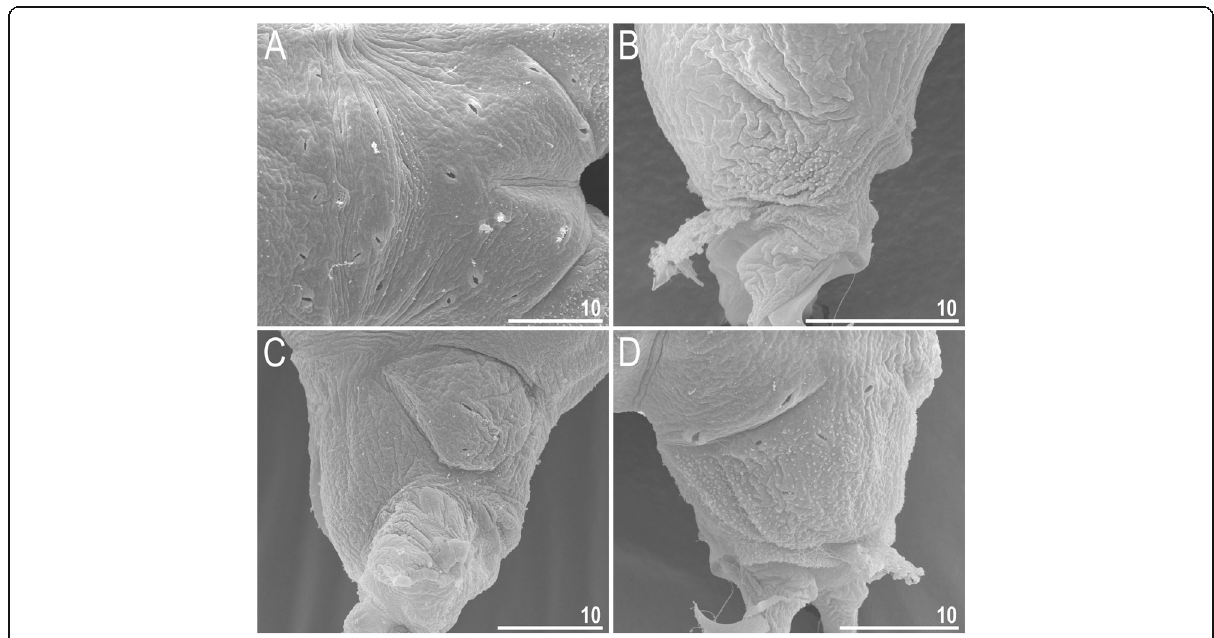
Fig. 32 Macrobiotus margoae sp. nov. from USA (US.057) – body and leg cuticle morphology seen with SEM: a – cuticle on the last body segment without caudal band of granulation; b – granulation on the external surface of leg III; c – internal surface of leg III with evident pulvinus; d – granulation on dorsal surface of leg IV. Scale bar in μ m.